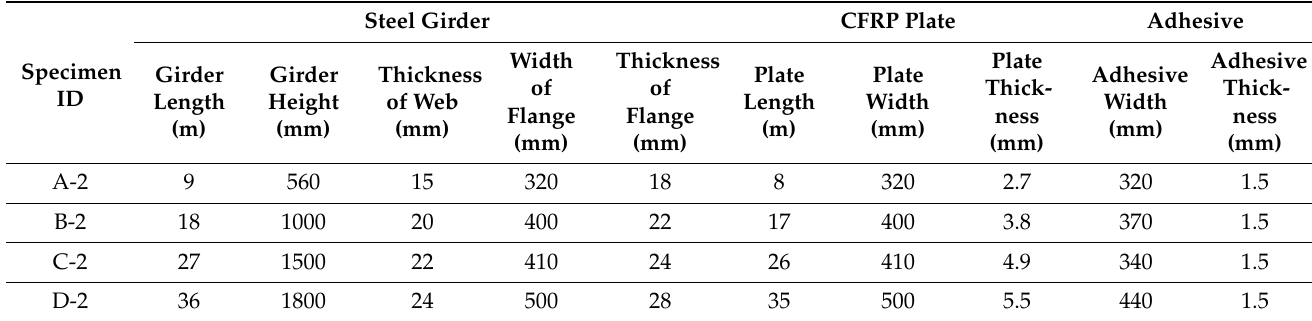
Table 2. The dimensions of specimens using Sika